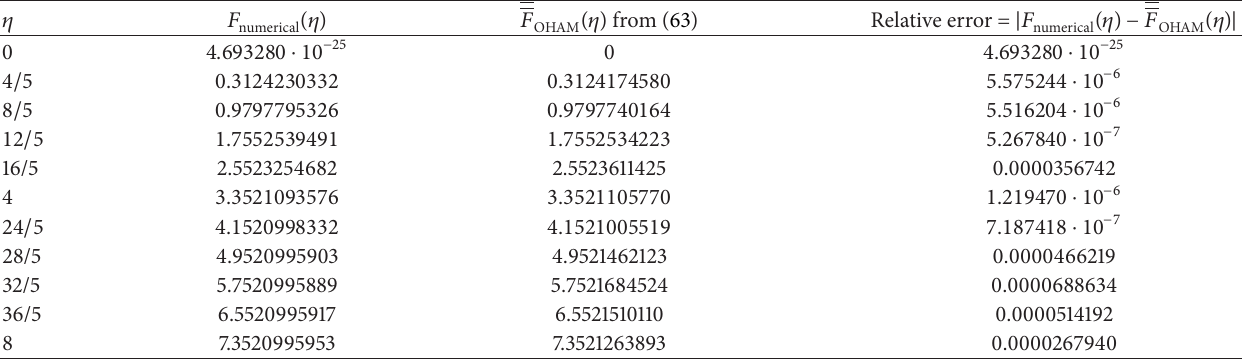
Table 16: Comparison between OHAM results given by (63) and numerical solutions for 𝛽 = 1 .